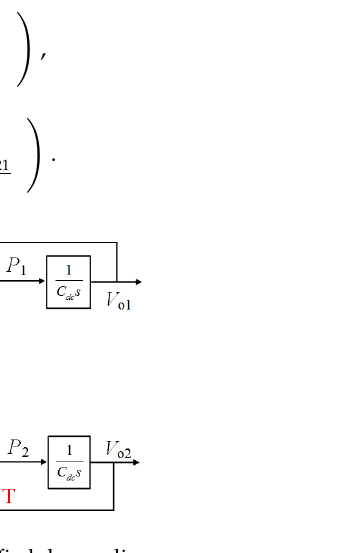
Figure 6. Control block diagram with simplified decoupling.